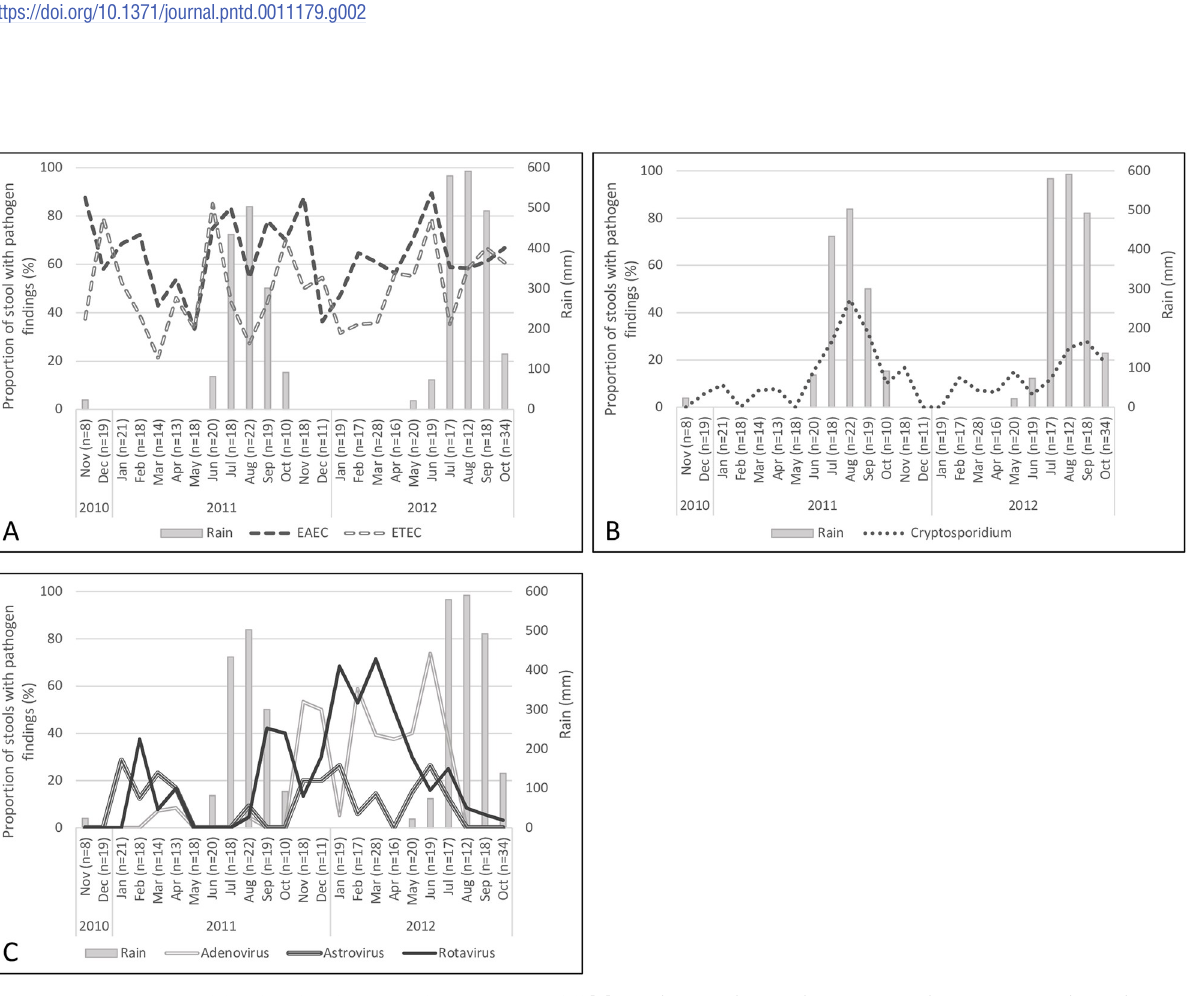
PLOS NeglectedTropical Diseases | https://doi.org/10.1371/journal.pntd.0011179 March 13,